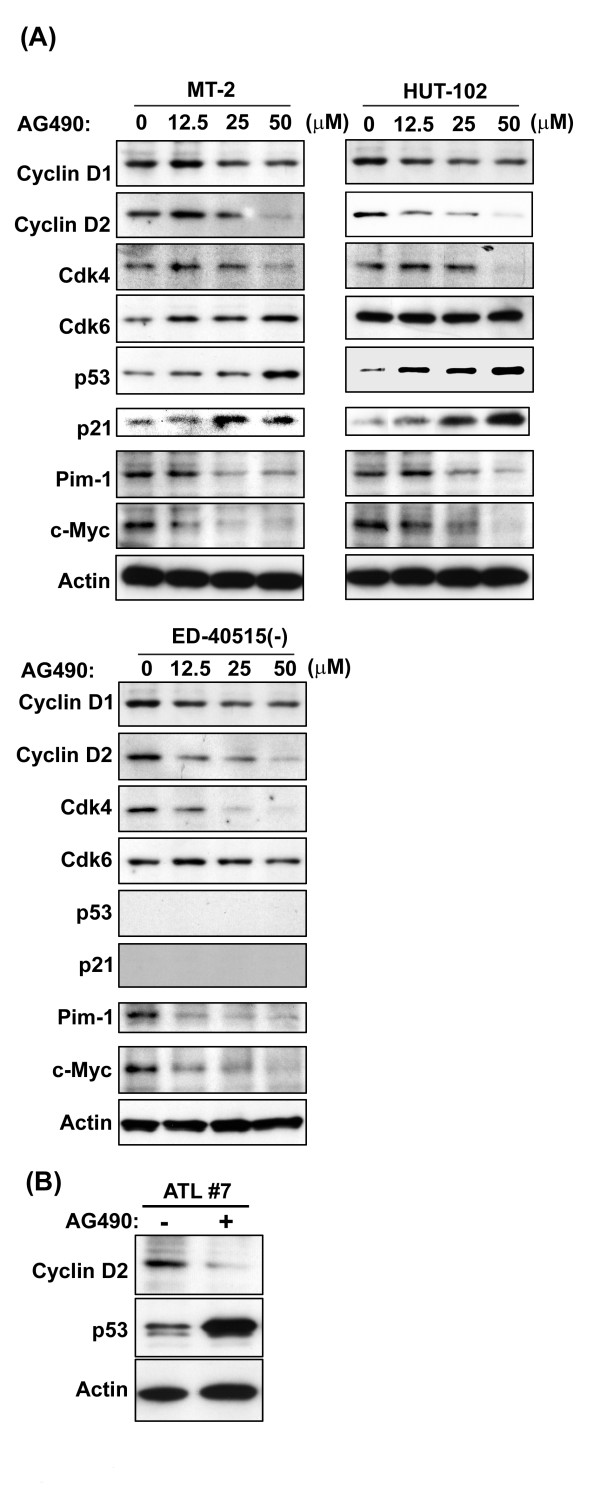
Effects of AG490 on the expression of cell-cycle associated proteins. HTLV-1-infected T-cell lines were treated with increasing concentrations of AG490 for 24 h. Amounts of cyclin D1, cyclin D2, Cdk4, Cdk6, p53, p21, Pim-1 and c-Myc were determined by Western blot analysis. (B) Primary ATL cells were treated with (+) or without (-) 50 μM AG490 for 24 h. The expression of cyclin D2 and p53 was assessed by Western blot analysis. The amount of actin is shown as a loading control.